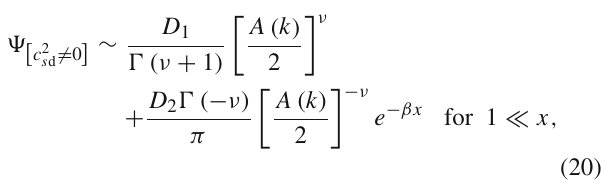
Fig. 5 This figure presents the evolution of the gravitational poten- tial, (cid:10) , with respect to its initial value, (cid:10) (cid:9) , in a logarithmic scale and from the present to the far future. The solid lines represent the positive values while the dashed lines represent negative values. We apply the